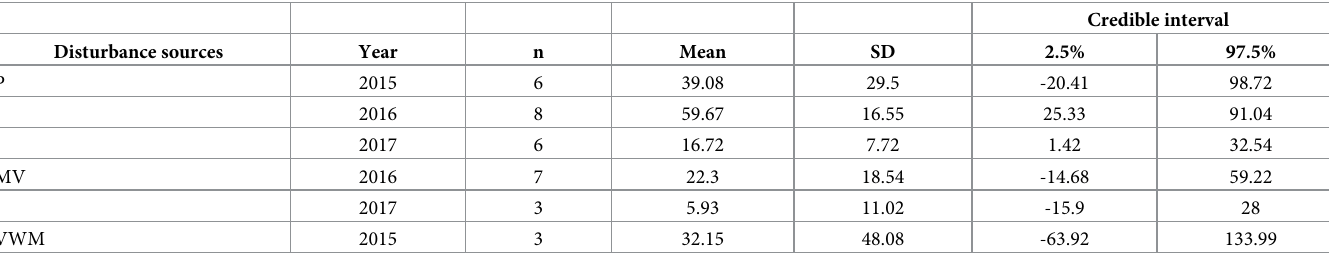
Table 3. Posterior summaries for recovery duration (min), by disturbance source.